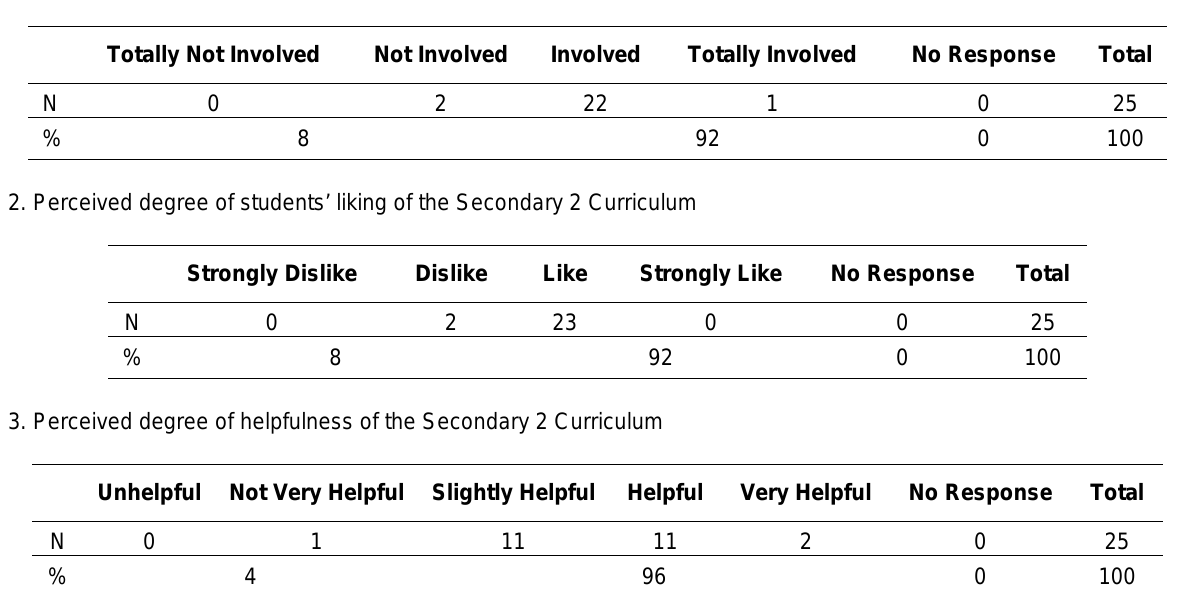
Instructors’ Ratings of the Secondary 2 Curriculum (N and